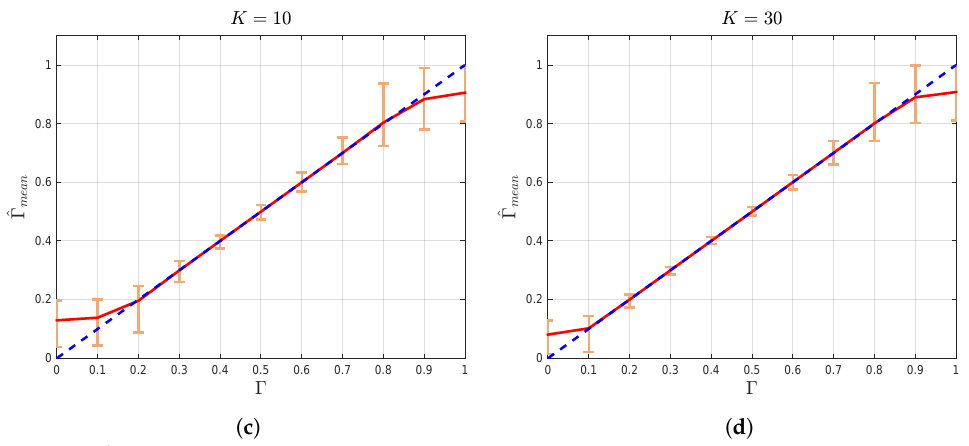
Figure 3. ˆ Γ mean (with absolute error bars) vs. Γ for ( a ) K = 1, ( b ) K = 3, ( c ) K = 10, and ( d ) K = 30. The solid line shows a linear regression fit to the data. The unit slope dashed line is illustrated as a